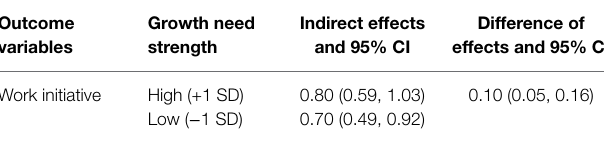
TABLE 8 | Indirect effect through work engagement at higher and lower levels of growth need strength. Outcome variables